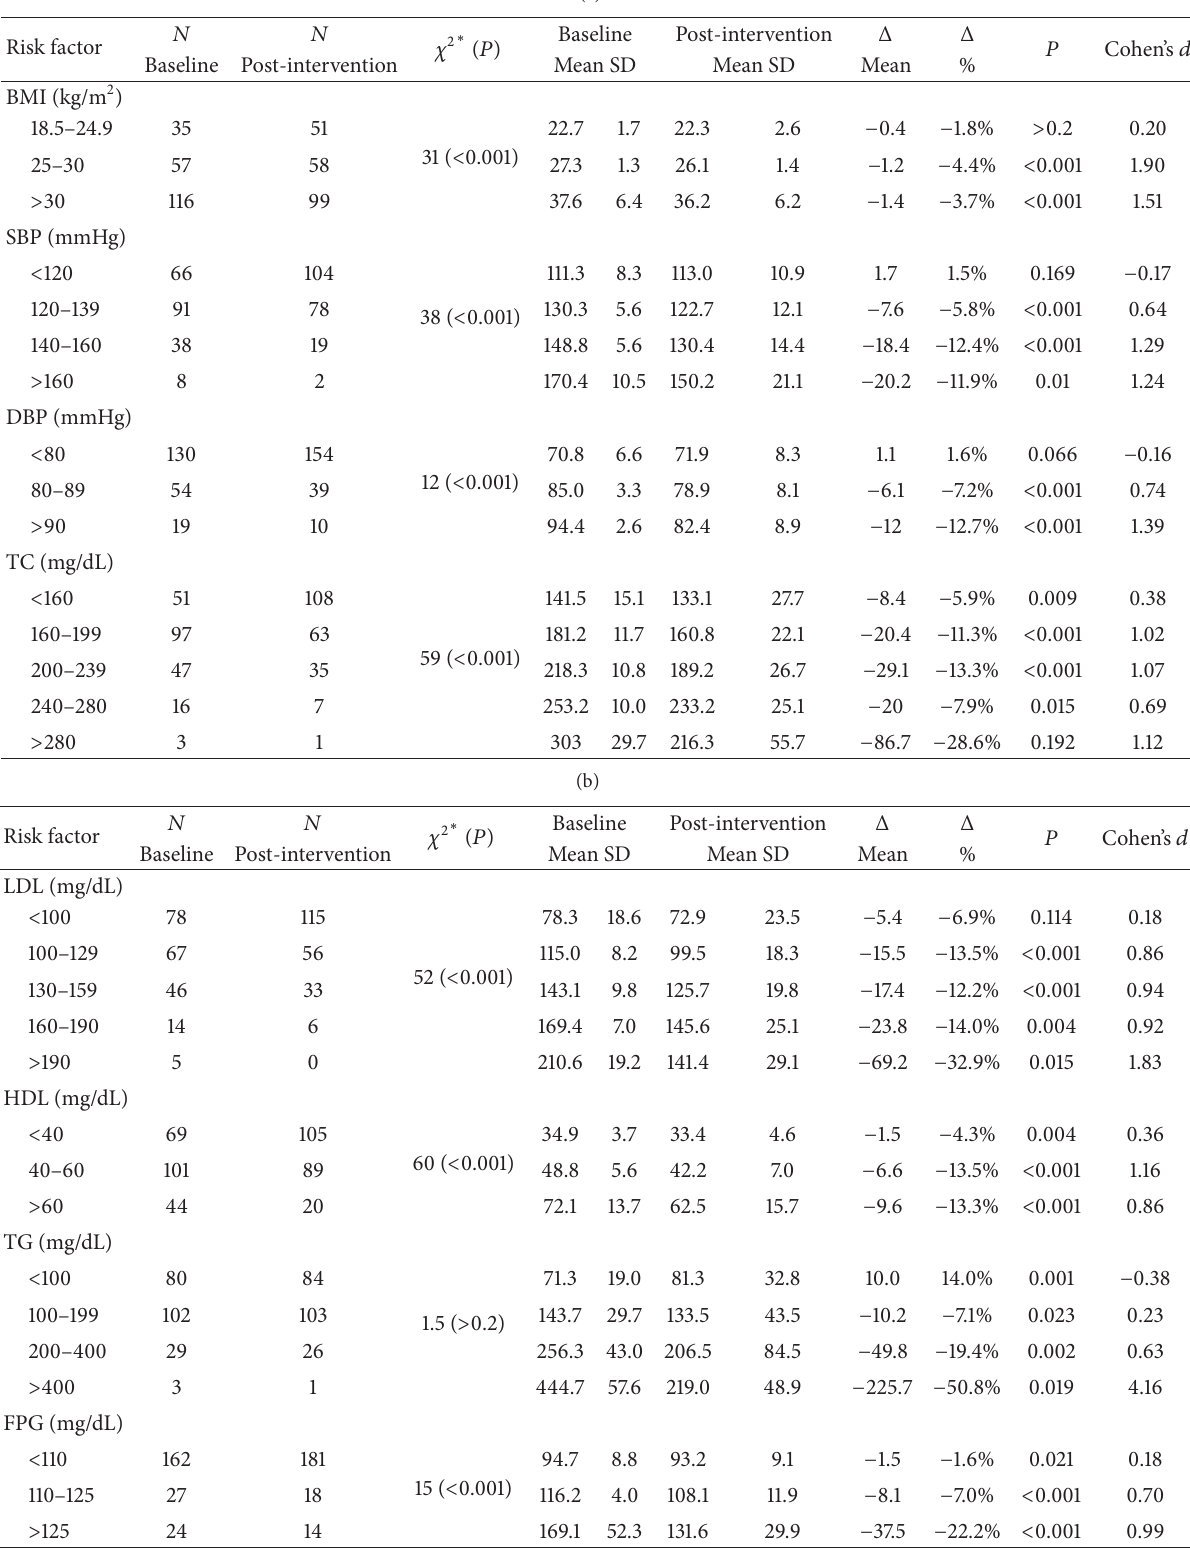
Table 3: (a) Changes in selected chronic disease risk factors according to initial risk classification on 225 participants of the Athens, OH, CHIP. (b) Changes in selected chronic disease risk factors according to initial risk classification on 225 participants of the Athens, OH,